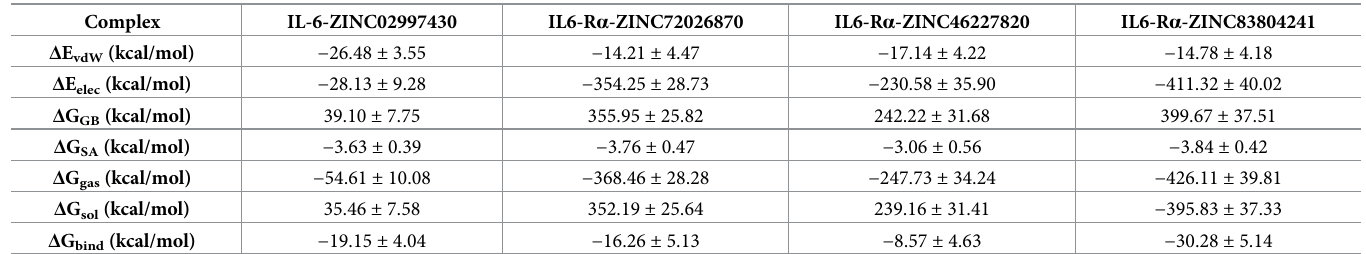
Table 5. The calculation of binding free energy results of 4 top hit ligands. Complex